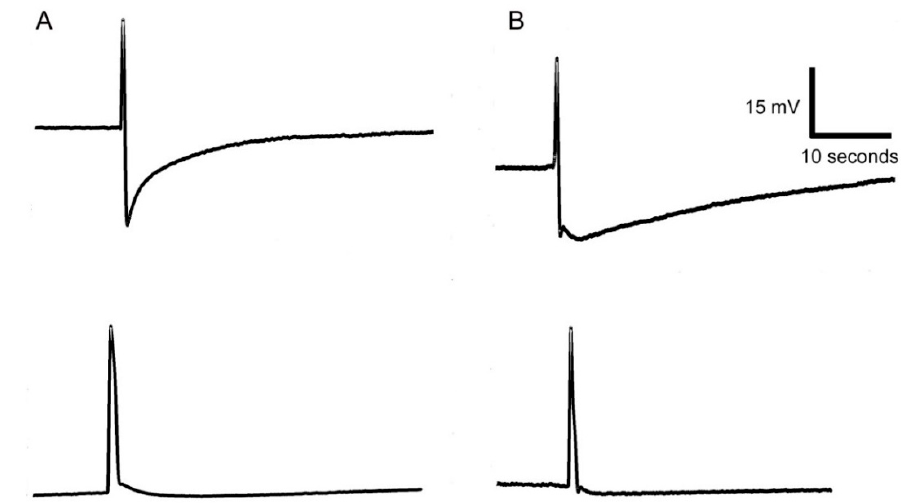
Figure 8. Action potentials recorded by electrode ( A ) and PANI-coated cotton fabric ( B ) in response to touching of trigger hair in Venus flytrap.